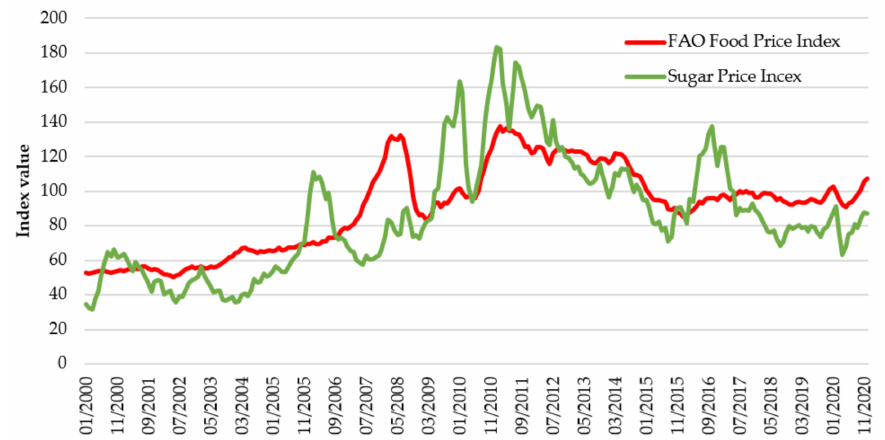
Figure 1. Food and Agricultural Organization of the United Nations (FAO) food price index and sugar price index for 2000–2020. Source: authors’ own elaboration based on FAO